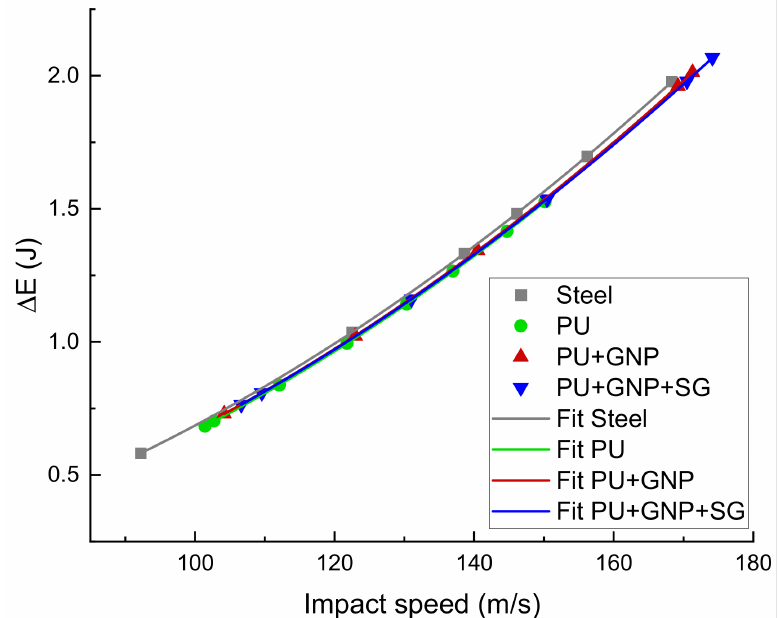
Figure 11. Change in kinetic energy resulting from the impact with the stationary